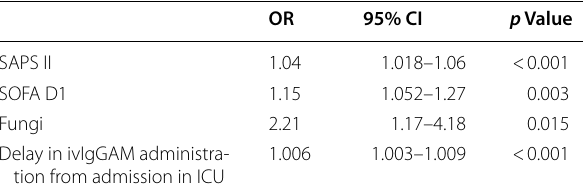
Table 3 Multivariable logistic regression analysis of risk factors for in-ICU